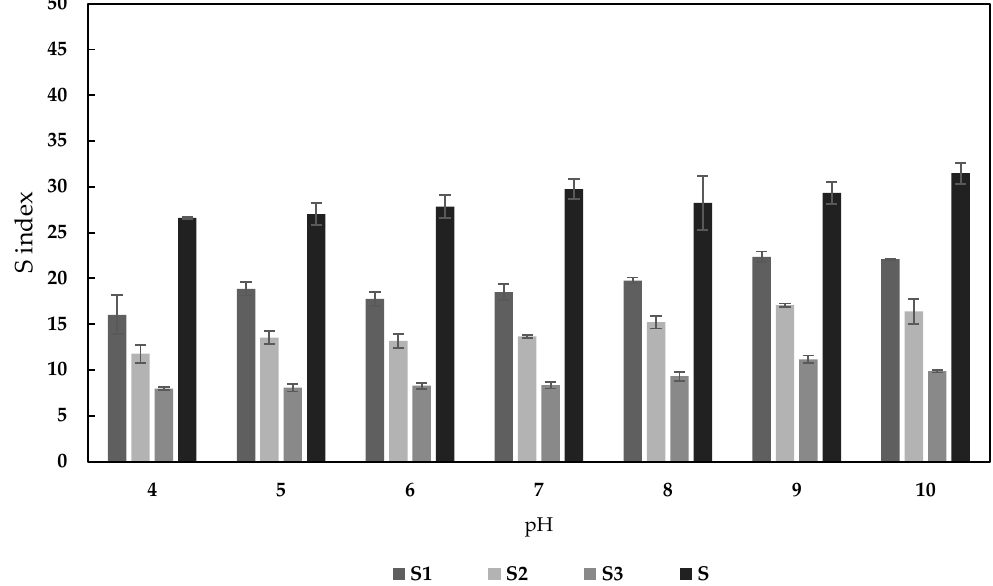
Figure 5. The e ff ect of pH on the swelling index of sorbents (m = 30 mg, V = 10 mL, c = 115 mg / L, temp. = 22 ± 1 ◦ C, t = 24 Figure 5. The effect of pH on the swelling index of sorbents (m = 30 mg, V = 10 mL, c = 115 mg/L, temp. = 22 ± 1 °C, t = 24 h).